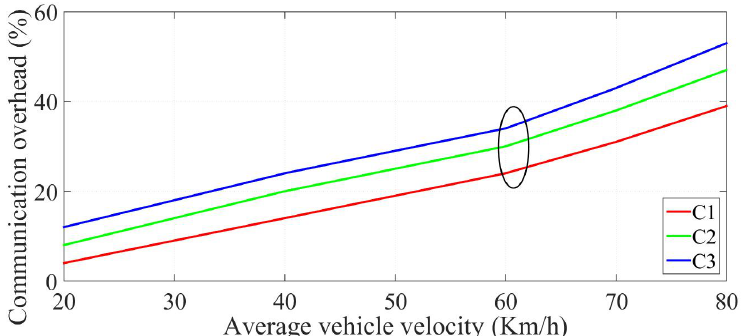
Figure 5. Percentage of the communication overhead with the change in the vehicle